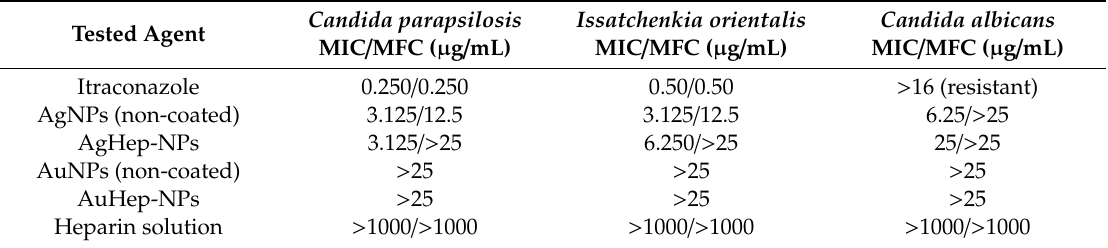
Table 1. MIC and MFC values of heparin-coated (AuHep-NPs and AgHep-NPs) and non-coated gold and silver NPs against Candida species, tested along with Itroconazole used as a control.